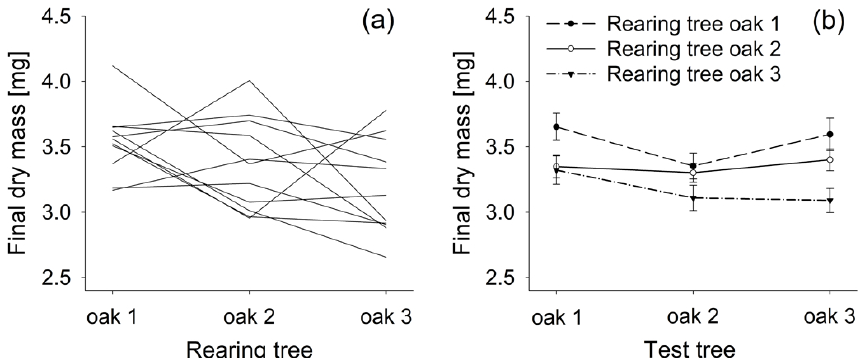
Figure 1. (a) Response of di ff erent families of Lymantria dispar to the three rearing trees. (b) E ff ect of the rearing tree and the test tree on the final dry mass of larvae of Lymantria dispar ( ± 1 standard error; for sample size see Methods section). Test trees are the leaves of tree individuals that larvae received after the transfer. We used the same three trees as rearing and test tree. A test tree could be the same as the rearing tree (control) or one of the two other trees (novel